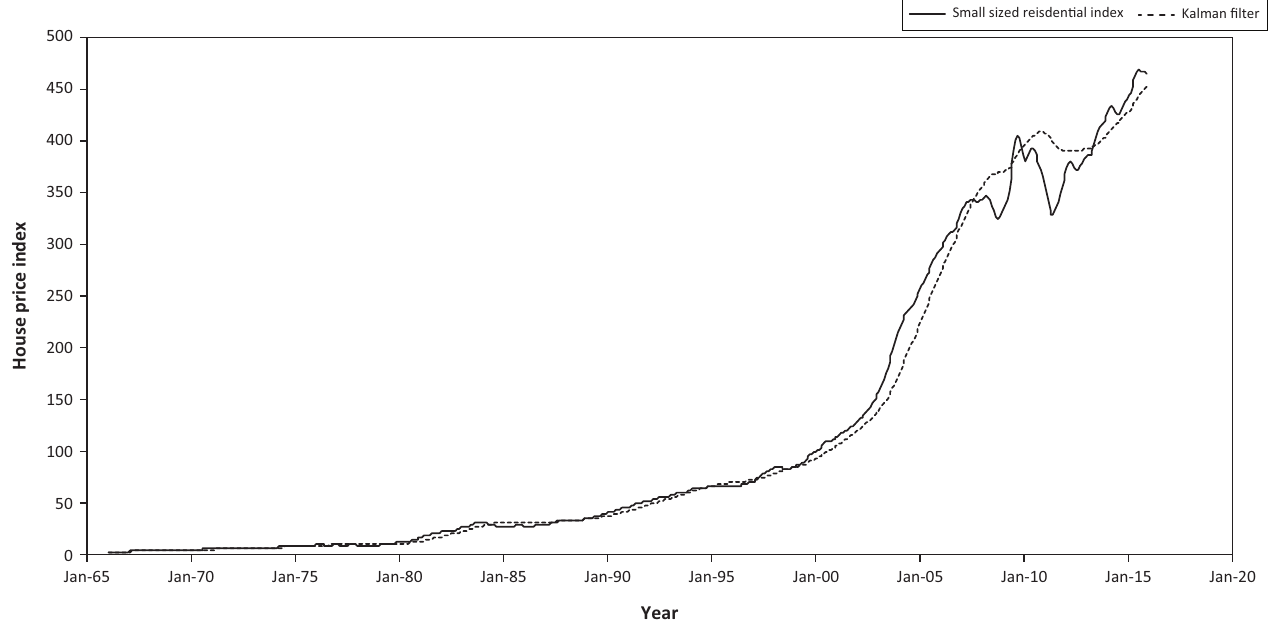
FIGURE 5: South African small residential price index and Kalman-filtered